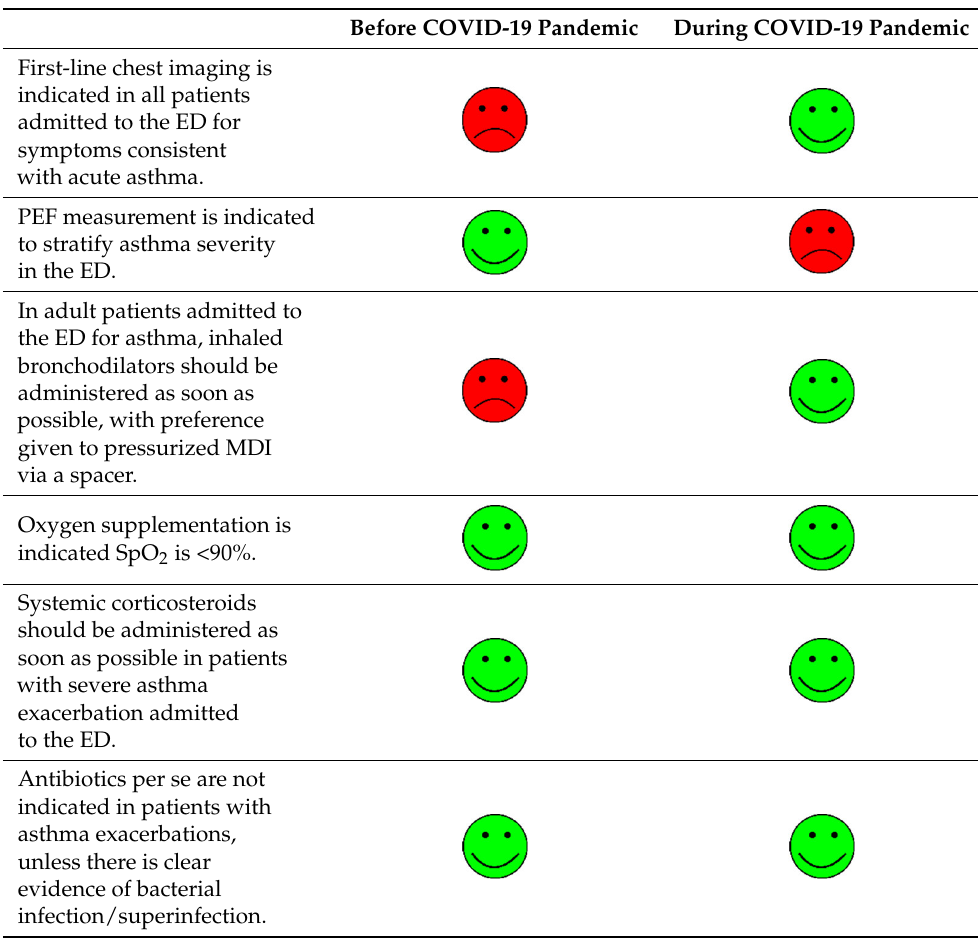
According to the available literature, clinical assessment of patients with asthma attacks admitted to the ED is crucial to decide whether to discharge, observe or hospitalize them [68–72]. Different levels of severity of asthma attacks (mild, moderate, severe, life threatening, fatal, brittle, etc.) influence this choice [34,73,74]. The coexistence of SARS- CoV-2 infection may lead emergency physicians to decide on hospitalization, concerned about the presence of two acute diseases with potential short-term recurrence or evolution [38,65,75–78]. However, as mentioned above, the association between asthma and SARS- CoV-2 infection should not in itself be an indication of hospitalization. The recovery rate was similar between asthmatics and non-asthmatics [79]. Hospitalization is recommended [3,30,31,54,55,80] for patients with: (1) Respiratory failure, severe respiratory distress, cyanosis, use of accessory muscles and altered mental status with impaired consciousness, after treatment and reassessment; (2) Hypoxia with SpO2 <92% after treatment and elevated PCO 2 >45 mmHg; near fatal asthma; presence of complications (e.g., pneumothorax, pneumomediastinum, atelectasis, arrhythmia); (3) History of previous severe asthma attacks (e.g., >3 ED visits or >2 hospitalizations in the past 12 months or previous intubation or management in ICU for asthma); (4) Poor family support or difficulty in reaching the hospital in case of further deterioration; (5) Significant medical comorbidities; psychological problems with concerns about compliance; (6) Recent steroid use;